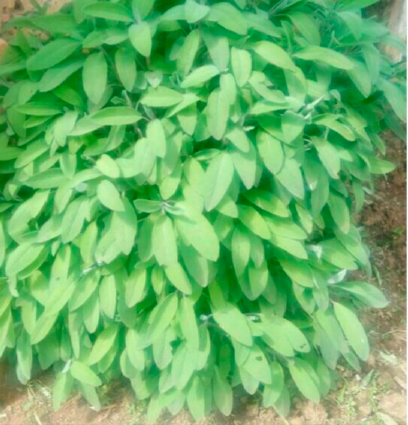
Figure 6. Salvia officinalis collected.